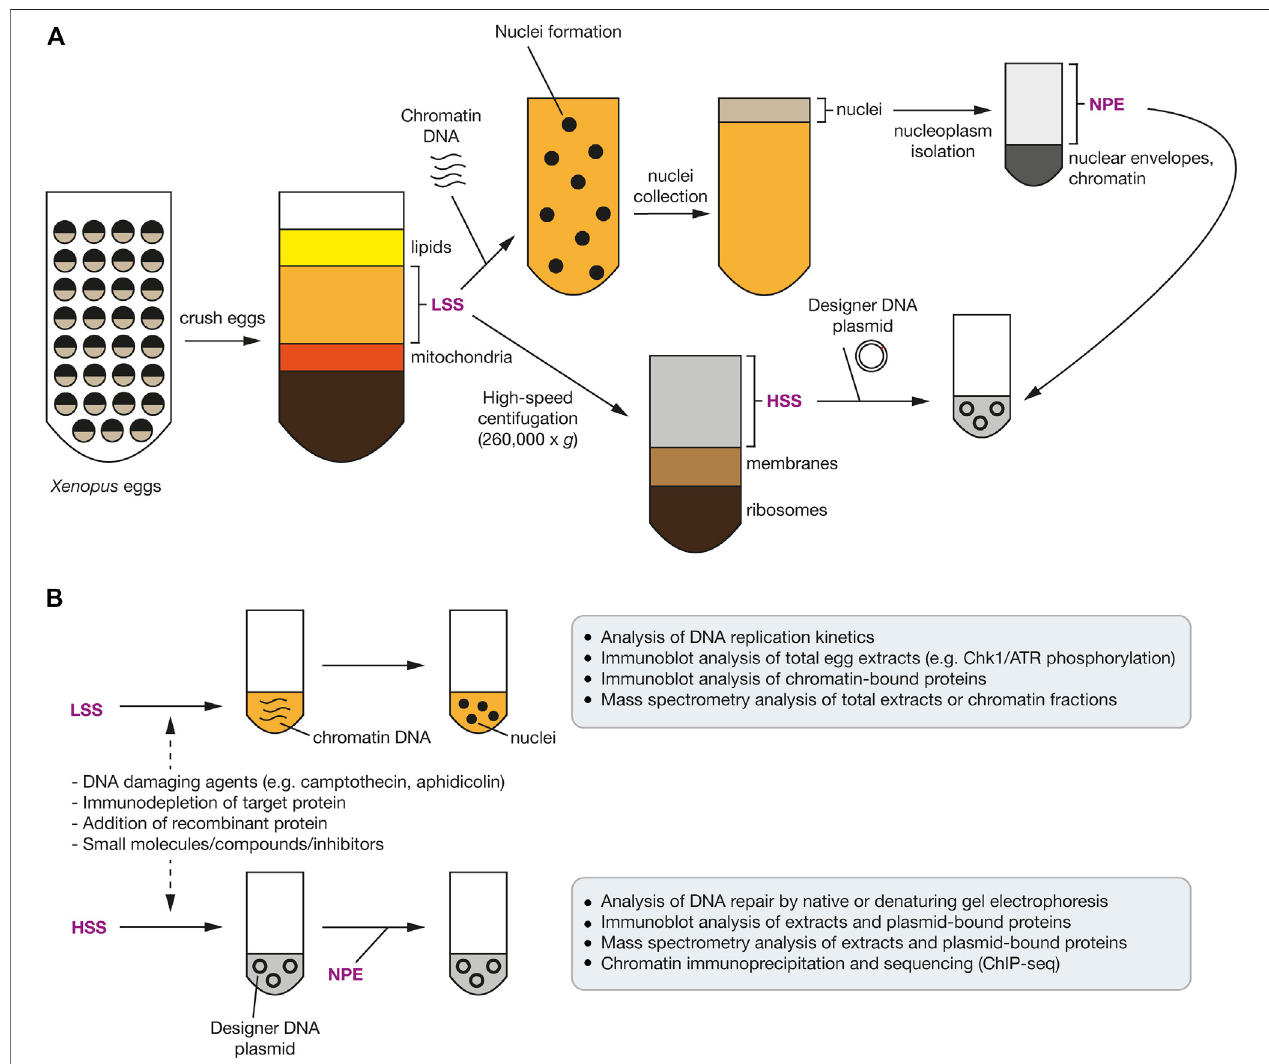
FIGURE 4 | Use of Xenopus egg extracts to investigate the DDR and ubiquitin signaling. (A) Schematic representation of the common steps involved in preparing Xenopus egg extracts. Unfertilised eggs are crushed and a low-speed centrifugation of the crude extract produces cytoplasmic extract including membranes (LSS). High- speed centrifugation produces cytoplasmic extract without membranes or ribosomes (HSS). Incubation of the LSS with sperm chromatin, in the presence of ATP, induces nuclear envelope formation. Nucleoplasm (NPE) can be isolated by centrifugation after isolating these nuclei. (B) Upon addition of sperm chromatin DNA to the LSS, nucleiformand chromatin DNA undergoesreplication. AdditionofDNA damaging agentscan beadded toactivate the DDR. Plasmid DNA witha de fi nedsite-speci fi c DNA lesion, such asa replication barrier or ICL, can be added tothe HSS,which isfurther supplemented with the NPE tostimulate DNA replication and repair ofthe site-speci fi c DNA lesion. In both systems, a protein-of-interest can be immuno-depleted with antibodies and rescued using recombinant wild-type or mutant proteins.